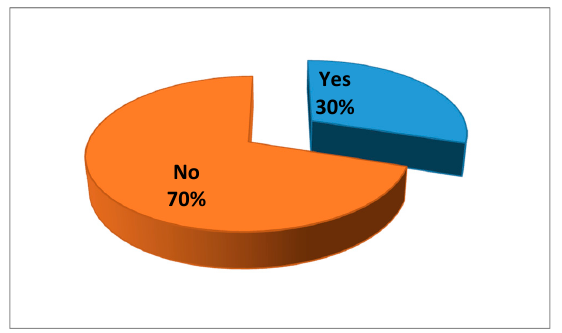
Figure 5. Are certain government agencies missing out in government actions targeting households? (according to the experts interviewed).